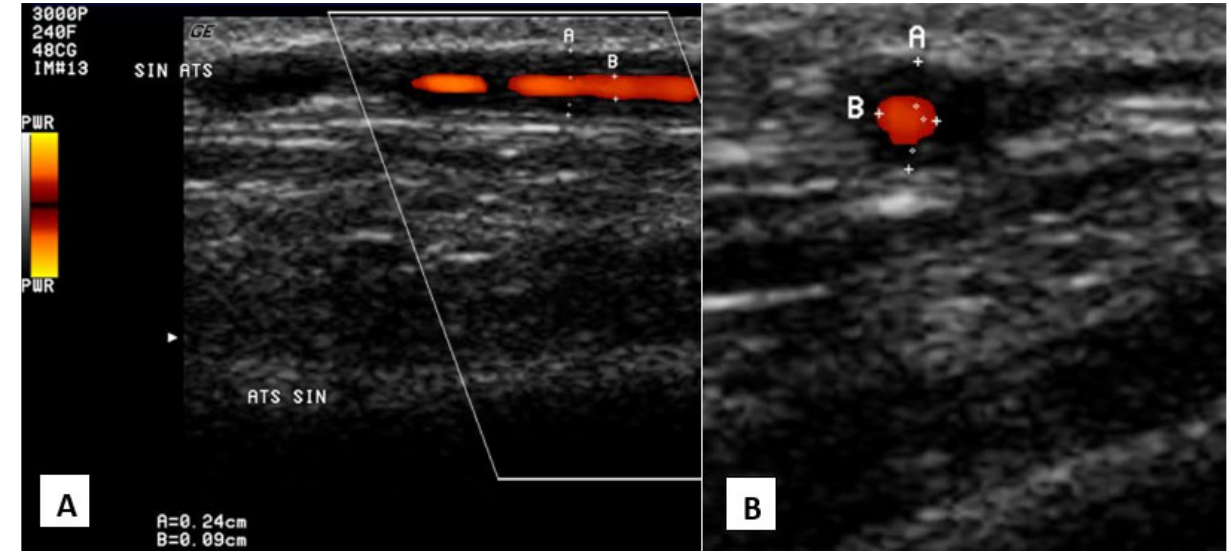
Figure 2. Giant cell arteritis in color-coded duplex ultrasound. “Halo” sign—circumferential hypoechoic vessel wall thickening around the lumen, attributable to vessel wall edema and intimal hyperplasia (superficial temporal artery, parietal ramus). A—longitudinal section, B—transverse section.